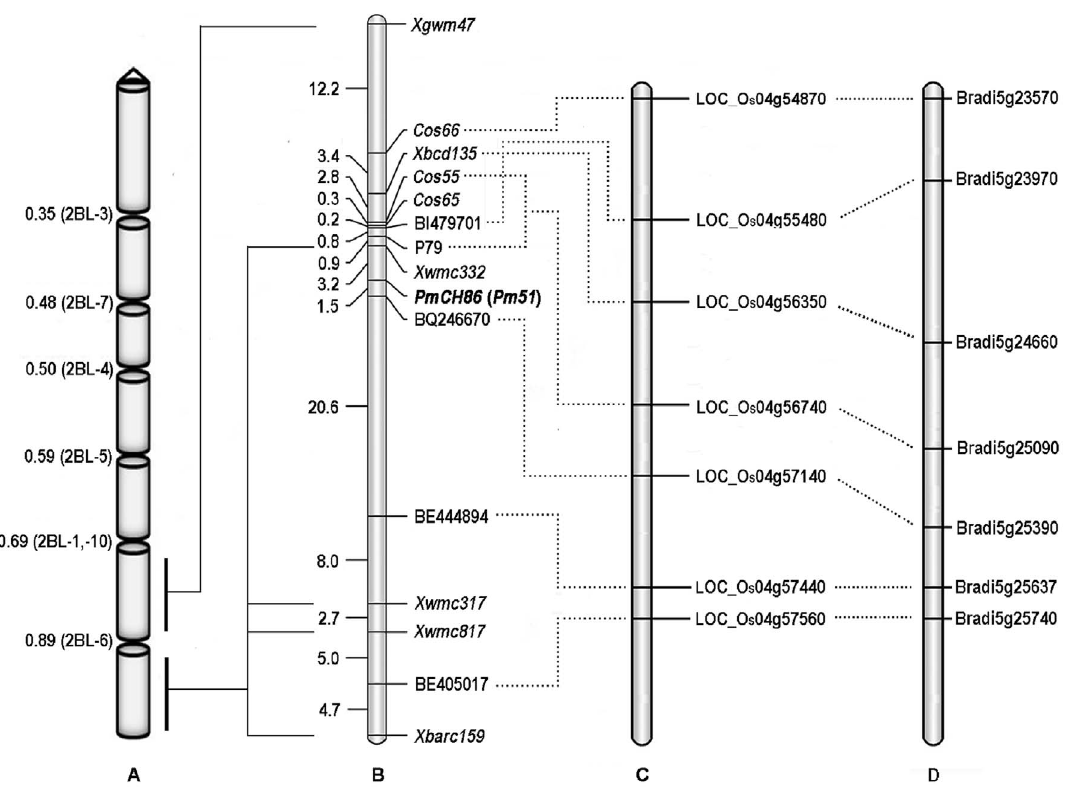
Figure 3. Genetic and comparative mapping of the PmCH86 gene. A) Chromosome physical map of 2BL (http://www.k-state.edu/wgrc/Germplasm/ Deletions/grp2L.html). B) Genetic map of wheat chromosome 2BL, only the region relatively close to PmCH86 was shown. Genetic distances are shown to the left in cM. C) The homologous region of PmCH86 with rice chromosome 4 (http://rice.plantbiology.msu.edu/). D) The homologous region of PmCH86 with Brachypodium chromosome 5 (http://www.brachypodium.org/database).